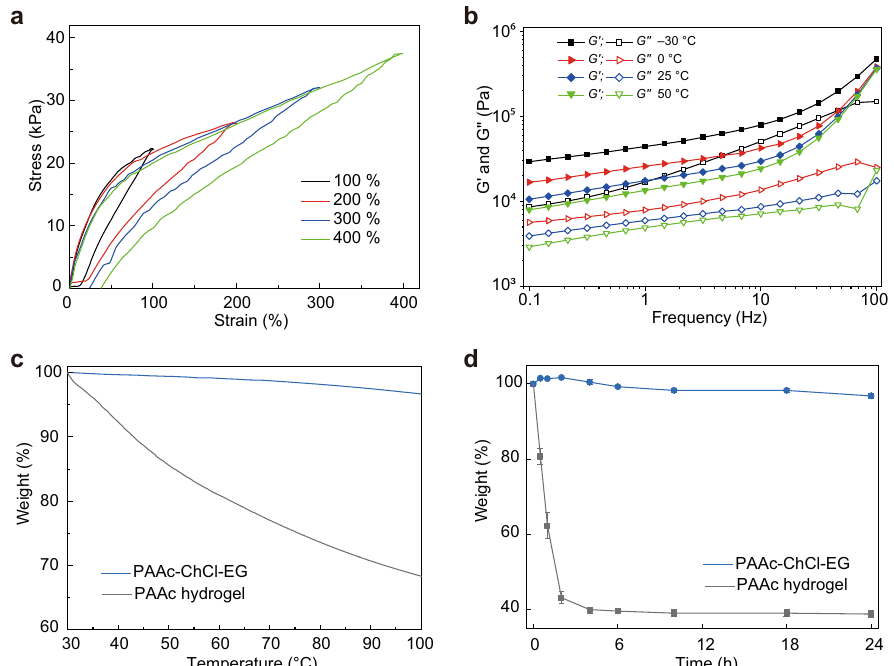
Fig. 2 Characterization of the PAAc – ChCl – EG gel. a Stress – strain curves of the gel in tension – unloading test with different elongations. b Storage modulus ( G ’ ) and loss modulus ( G ” ) of the gel in different frequencies and at different temperatures. c TGA curve of the PAAc – ChCl – EG and the PAAc hydrogel. d Evolution of mass with the time of the PAAc – ChCl – EG and PAAc hydrogel at 37 °C. Values in panel d represent the mean and standard deviation ( n =